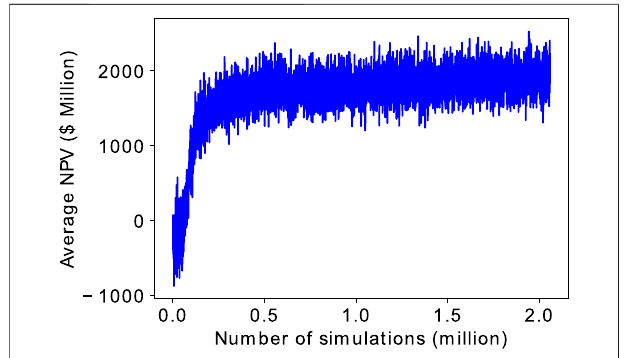
FIGURE 5 | Evolution of the average NPV using the single-action probability distribution for the 2D